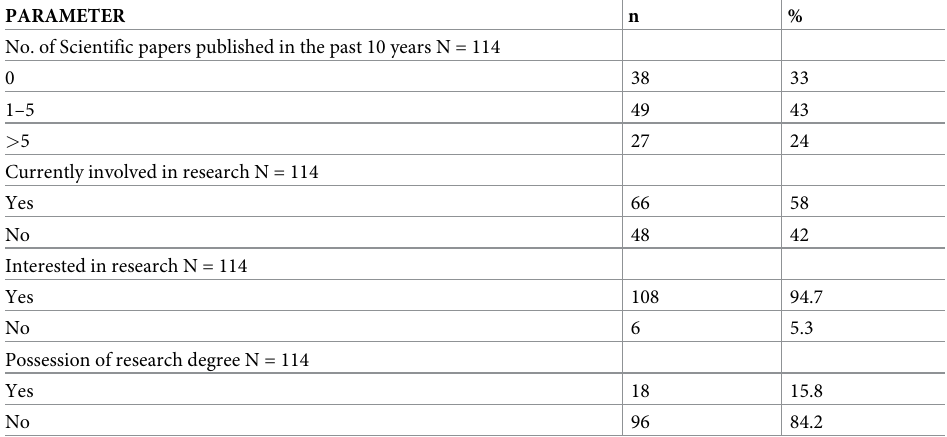
Table 4. Academic and research profiles.